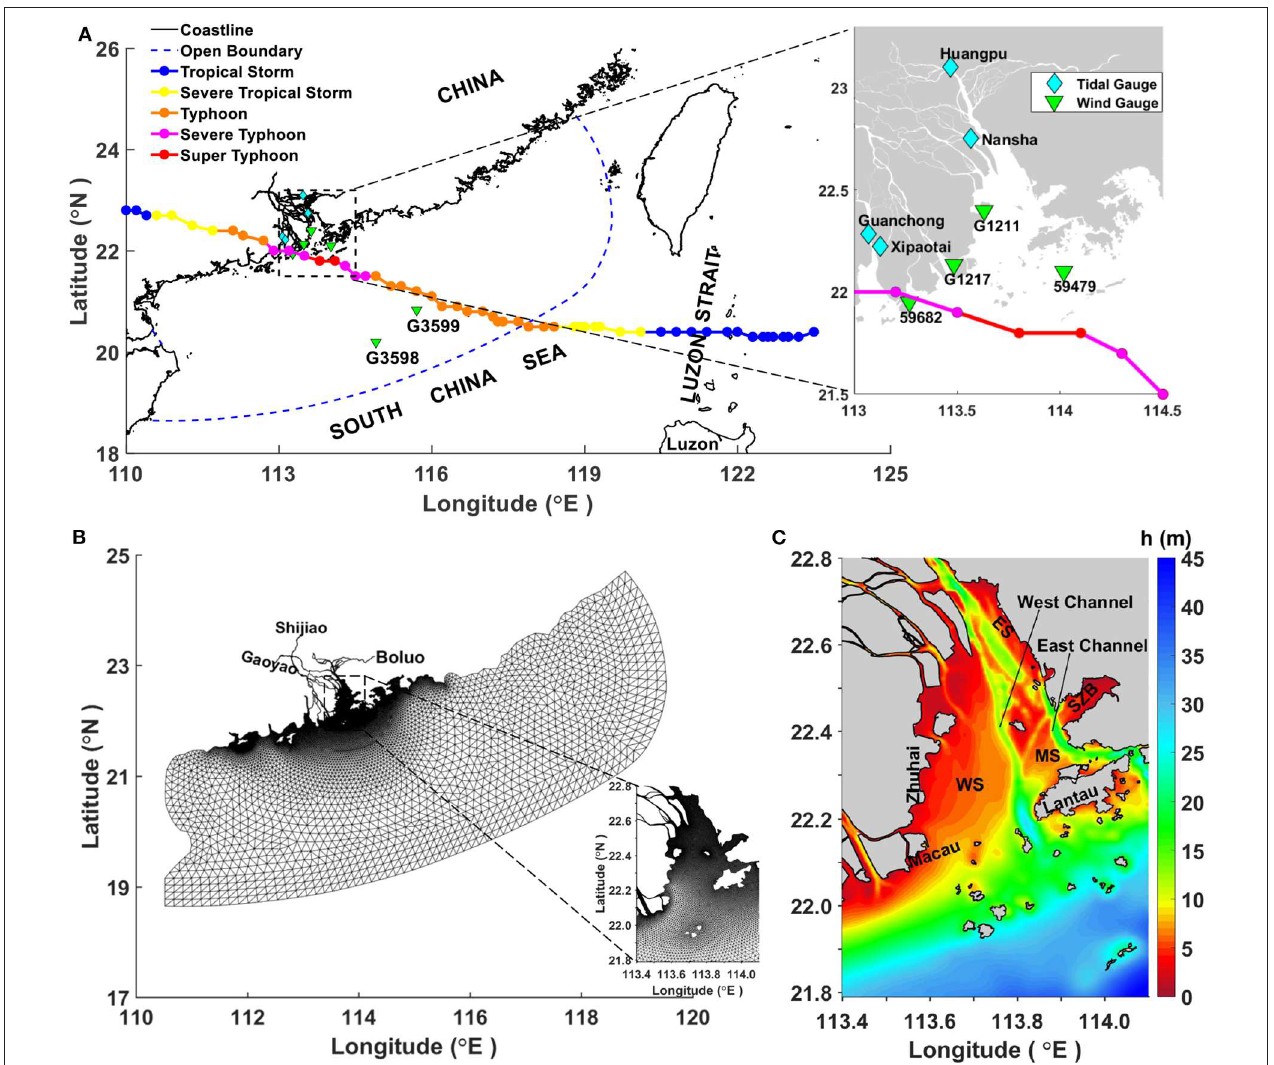
FIGURE 1 | (A) The track and intensity of Typhoon Hato, which crossed the Pearl River Estuary in August 2017. The model domain is bordered by blue dashed lines. The six downward-pointing triangles indicate the locations of wind gauges; the four diamonds represent the locations of tidal gauges. The information on the typhoon track is provided by Zhejiang Water Resources Department (typhoon.zjwater.gov.cn) and that on typhoon intensity is provided by HongKong Observatory (HKO, 2017). (B) The unstructured model grid, which includes 97,602 triangular elements and 56,993 nodes in total; the names of three hydrological stations located at the model’s river boundaries are also indicated. (C) Zoomed-in bathymetry around the PRE and its adjacent shelf waters. WS, West Shoal; MS, Middle Shoal; ES, East Shoal; SZB, Shenzhen